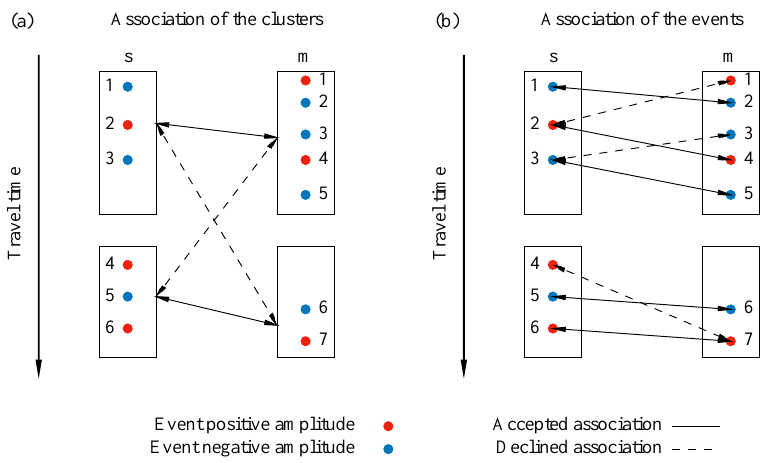
Figure 5. Example of the association of simulated (s) and measured (m) events with indices 1–6 and 1–7, respectively. The color of the dots indicates the sign of amplitude of the events. (a) The detected events (Fig. 4) are aggregated in clusters to minimize the number of possible event combinations. The clusters are associated such that the summed absolute travel time difference of the mean travel time of the events in the cluster is minimal. (b) The events in the clusters are associated according to consistent temporal order and amplitude sign. Hence, if (t s , 1 ,A s , 1 ) is associated with event (t m , 2 ,A m , 2 ) , event (t s , 2 ,A s , 2 ) cannot be associated with event (t m , 1 ,A m , 1 ) , if t m , 1 < t m , 2 or sign (A s , 2 ) (cid:54)= sign (A m , 1 ) . Solid (dashed) arrows indicate some of the accepted (declined) association combinations. The combination with the maximal number of associations and minimal summed absolute travel time difference is used for evaluation. Thus, for example (t s , 1 ,A s , 1 ) is associated with (t m , 2 ,A m , 2 ) and not with (t m , 3 ,A m , 3 ) .